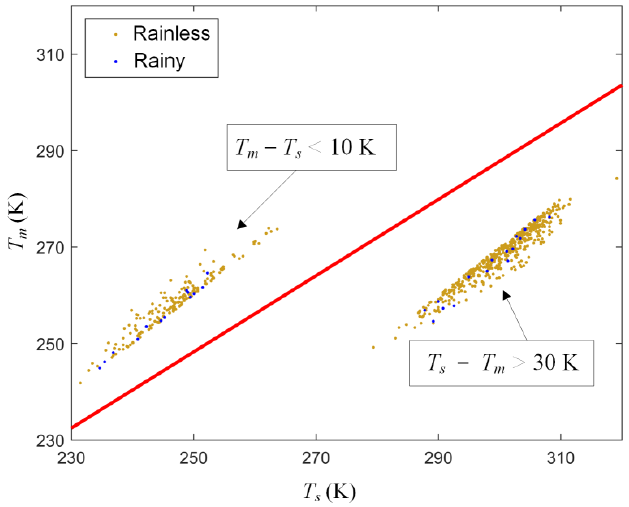
Figure 12. Data points from the radiosonde profiles that satisfy T m − T s > 10 K and T s − T m > 30 K. The red line is the unified T s ∼ T m linear model, the same as that shown in Figure 2. The golden dots are the data from rainless days and the blue dots are those from rainy days.